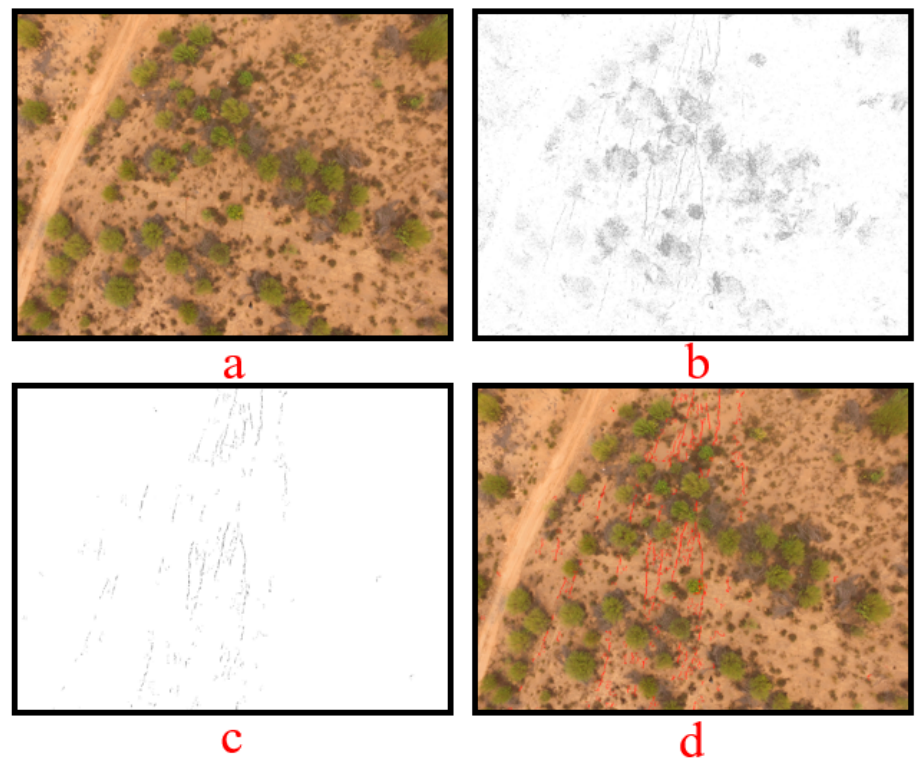
Figure 10. Final schematic diagram of the crack extraction e ff ect in the UAV image. ( a ) is the original UAV image, ( b ) is the schematic diagram of the crack extraction e ff ect by edge segmentation for the original UAV image, ( c ) is the schematic diagram of the crack extraction e ff ect by edge segmentation for the UAV image after the method mentioned in this article, and ( d ) is the comparison of the final schematic diagram of the crack extraction e ff ect in the UAV image and original UAV image.